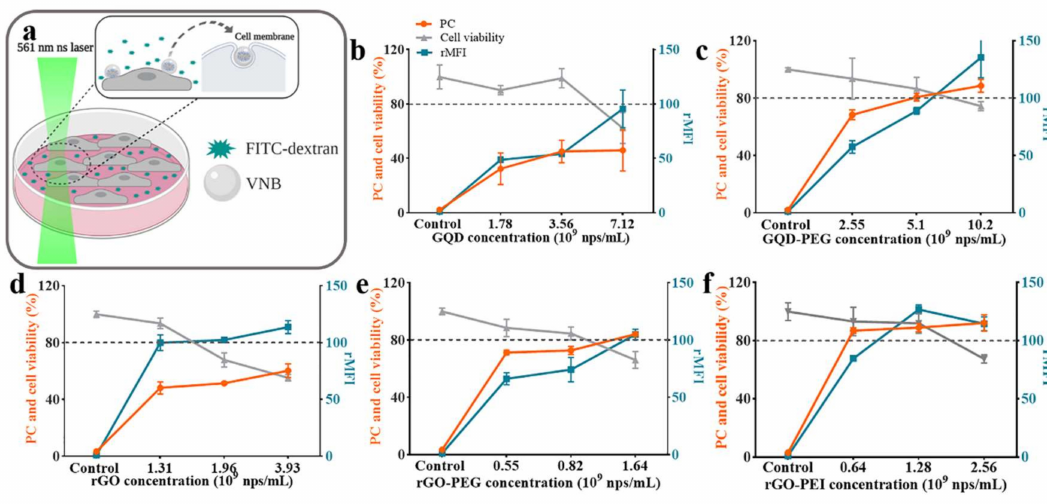
Figure 3. FD10 delivered into living HeLa cells by photoporation with graphene-based materials. ( a ) Conceptual illustration of the photoporation experiment. Created with Biorender.com. ( b – f ). Quantification by flow cytometry of the percentage of FD10 positive cells (PC) and relative mean fluorescence intensity (rMFI) (MFI compared to control cells). Cell viability was determined by CellTiter-Glo ® 2 h after the photoporation. The same protocol was applied to control cells but in the absence of nanoparticles. ( b ) GQD, ( c ) GQD-PEG, ( d ) rGO, ( e ) rGO-PEG, and ( f )